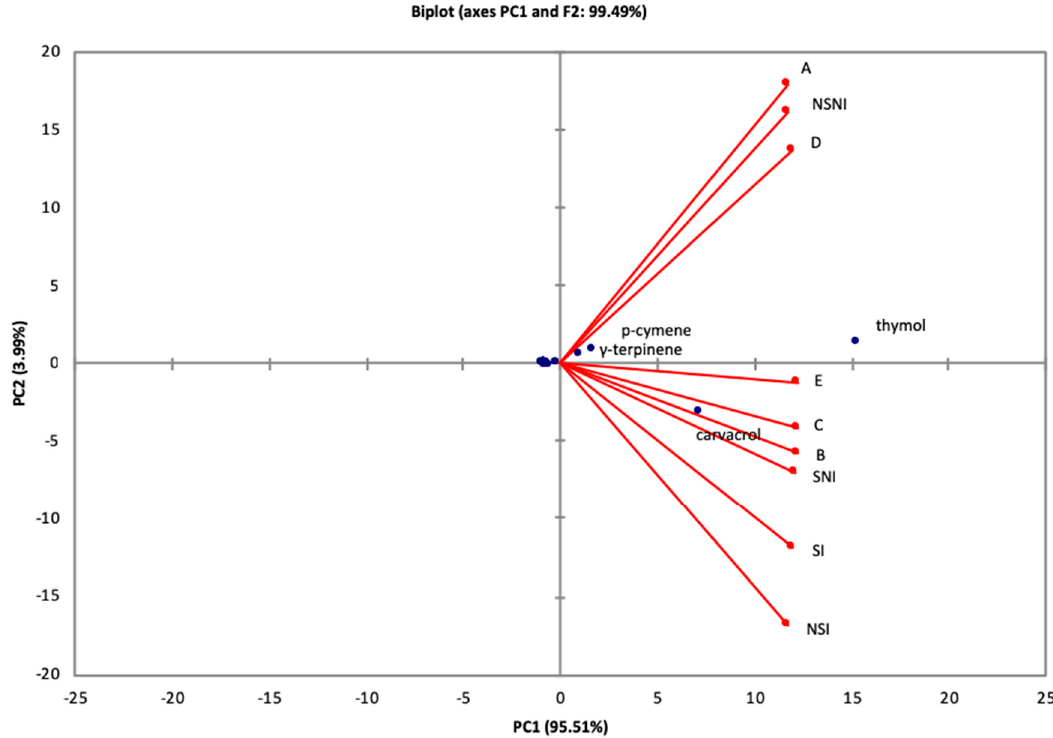
Figure 1. Principal component projection plot of principal components PC1 and PC2 scores and loadings indicating chemotypes within Origanum syriacum based on chemical composition of the essential oils.